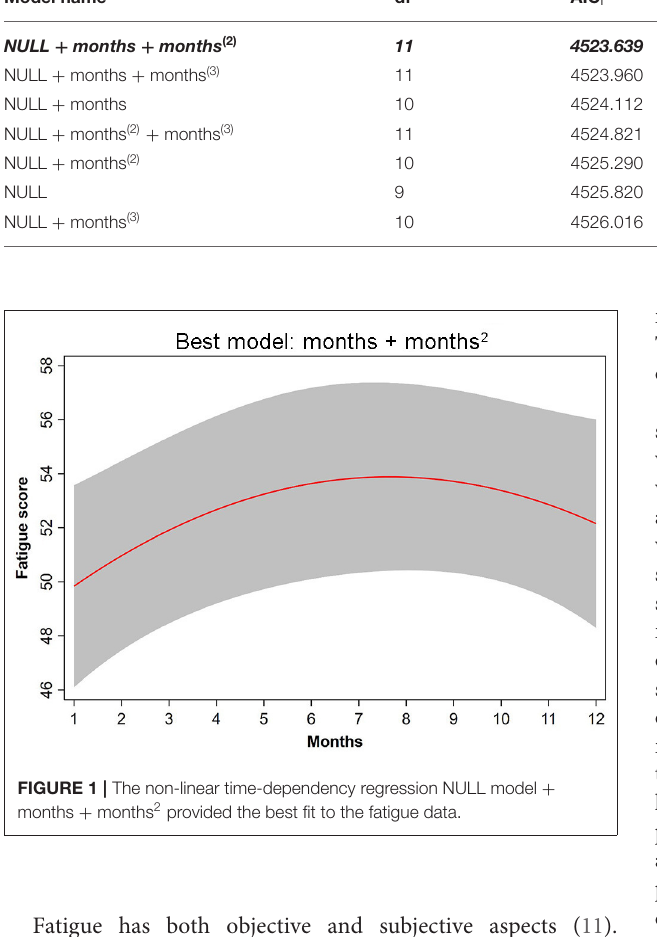
Fatigue has both objective and subjective aspects